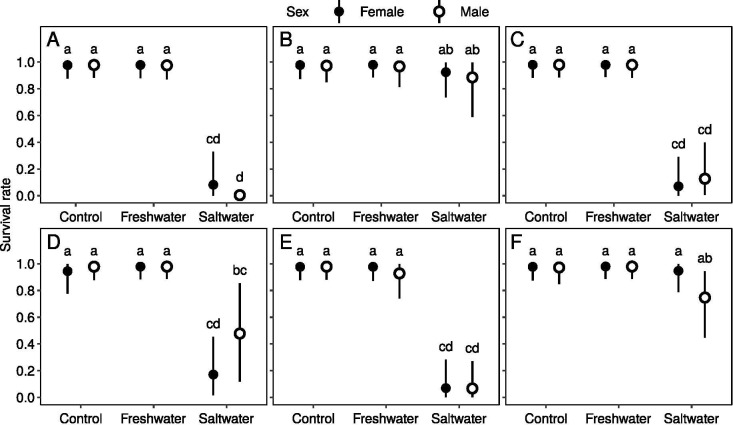
Survival rates in three sequent days in six lizard species, P. elegans (A), E. longicaudata (B), D. swinhonis (C), H. frenatus (D), A. sagrei (E) and E. multifasciata (F), in Taiwan. Circles and vertical bars present the posterior mean and 95% credible intervals on the survival rate, respectively. Letters above the bars present the results of the post hoc comparisons; two groups sharing the same letter(s) indicate no significant difference.